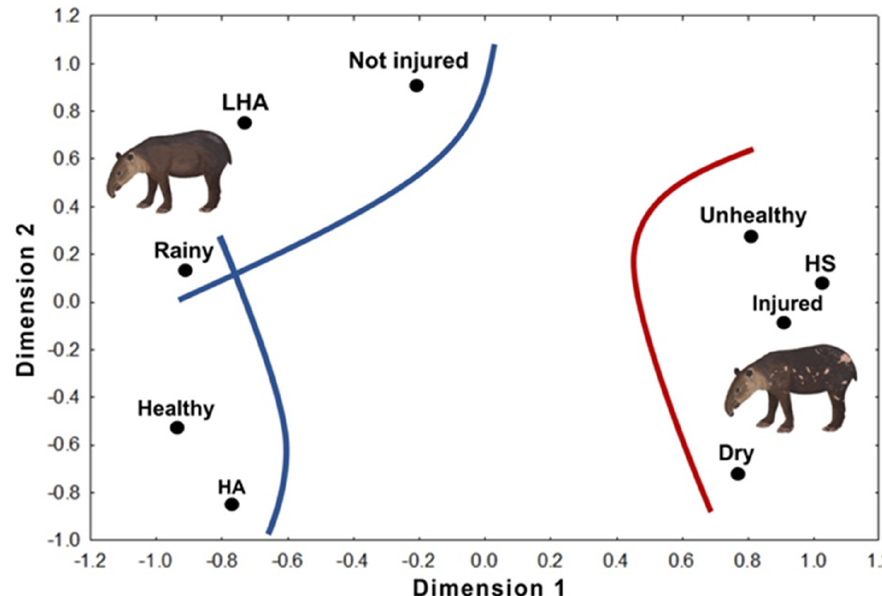
Figure 6. Distribution of the variables (seasonality, health, injuries and categories of areas based on the distance to settlements). The blue curves include variables associated with healthy or uninjured individuals. The red curve congregates variables associated with unhealthy individuals. HS = human shield, HA = human activity and LHA = low human activity.